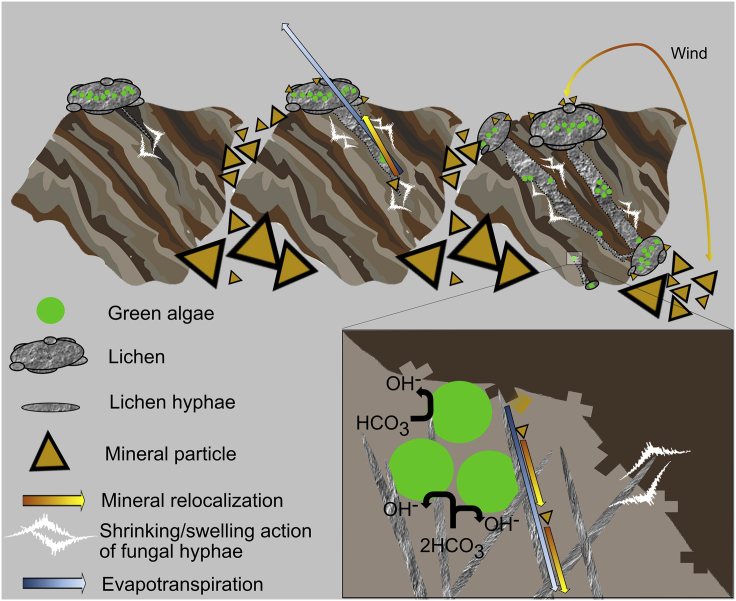
Schematic Overview of Bioweathering ProcessesLichens consisting of a mycobiont and its hyphae (gray) together with green algal photobionts (green) colonize polycrystalline grit stones (brown tones) that have a size of roughly 6 mm. The hyphae of the lichen penetrate the lithomatrix causing tunnels induced by shrinking and swelling actions (white arrow) induced by fog and water input that hydrate the lichen. Further bioweathering activity (depicted in the inlet) leads to solubilization of minerals during times of hydration as a consequence of photosynthetic activity of the green algae photobionts. These excrete OH− as a byproduct into the lithomatrix which causes alkalization that can promote the dissolution of e.g. quartz and other minerals. These minerals can be relocated (yellow arrow) following the direction of evapotranspiration (blue arrow) and re-crystallize (yellow triangles) on the surface of the lichen. On the surface of the lichens which is sticky due to excreted mucus like substances, mineral particles can accumulate between the grit stones from where they can be re-transported by wind (yellow arrow) which in turn can also lead to the accumulation of fine material on the lichen's surface.